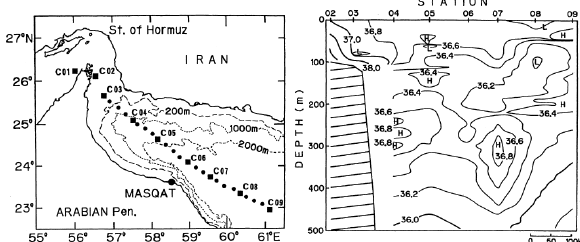
Fig. 18. Locations of CTD measurements during January 1994 (Senjyu et al., 1998) and the corresponding salinity